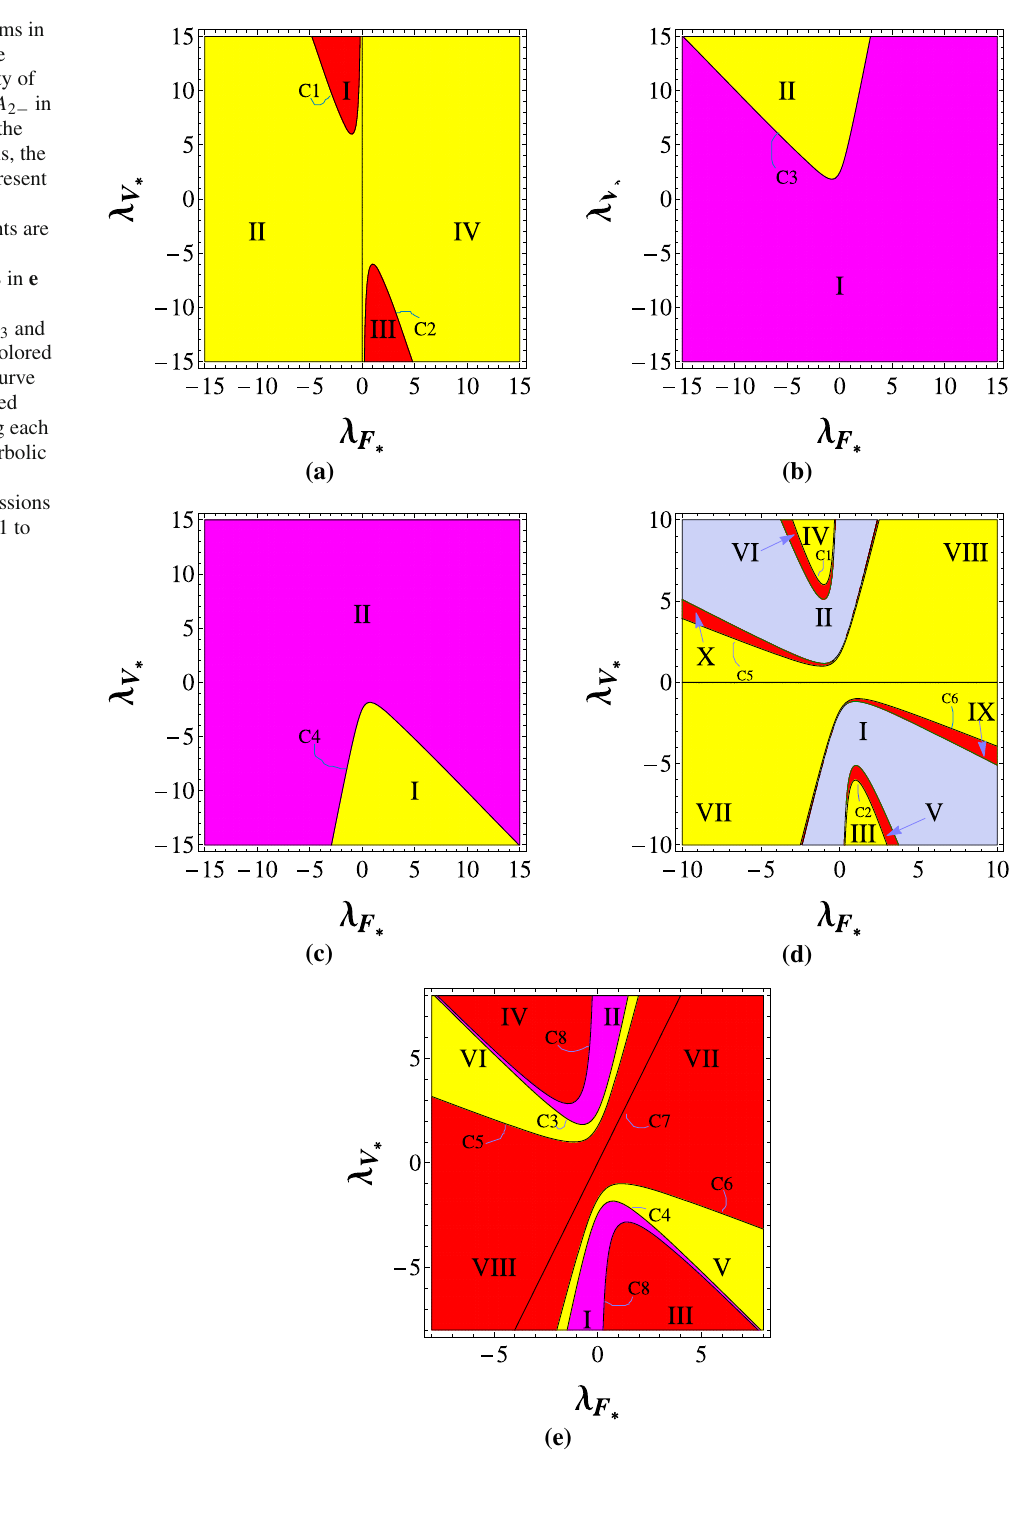
Fig. 1 Bifurcation diagrams in (λ ,λ ) parameter space F ∗ V ∗ exhibiting the local stability of points A 1 in a , A 2 + in b , A 2 − in c , A 3 in d and A 4 in e for the case of w = 0. In all panels, the yellow shaded regions represent the regions where the corresponding critical points are saddle. Black colored line λ = 0 in d and curve C8 in e V ∗ corresponds to the non-existence of a point A 3 and A 4 respectively. A green colored curve in d represents the curve where (cid:14) = 0. Black colored curves C1 to C7 separating each region represent non-hyperbolic curves. The curve C7 is 2 λ F ∗ = λ V ∗ . For the expressions corresponding to curves C1 to C6, we refer to the text in Statement